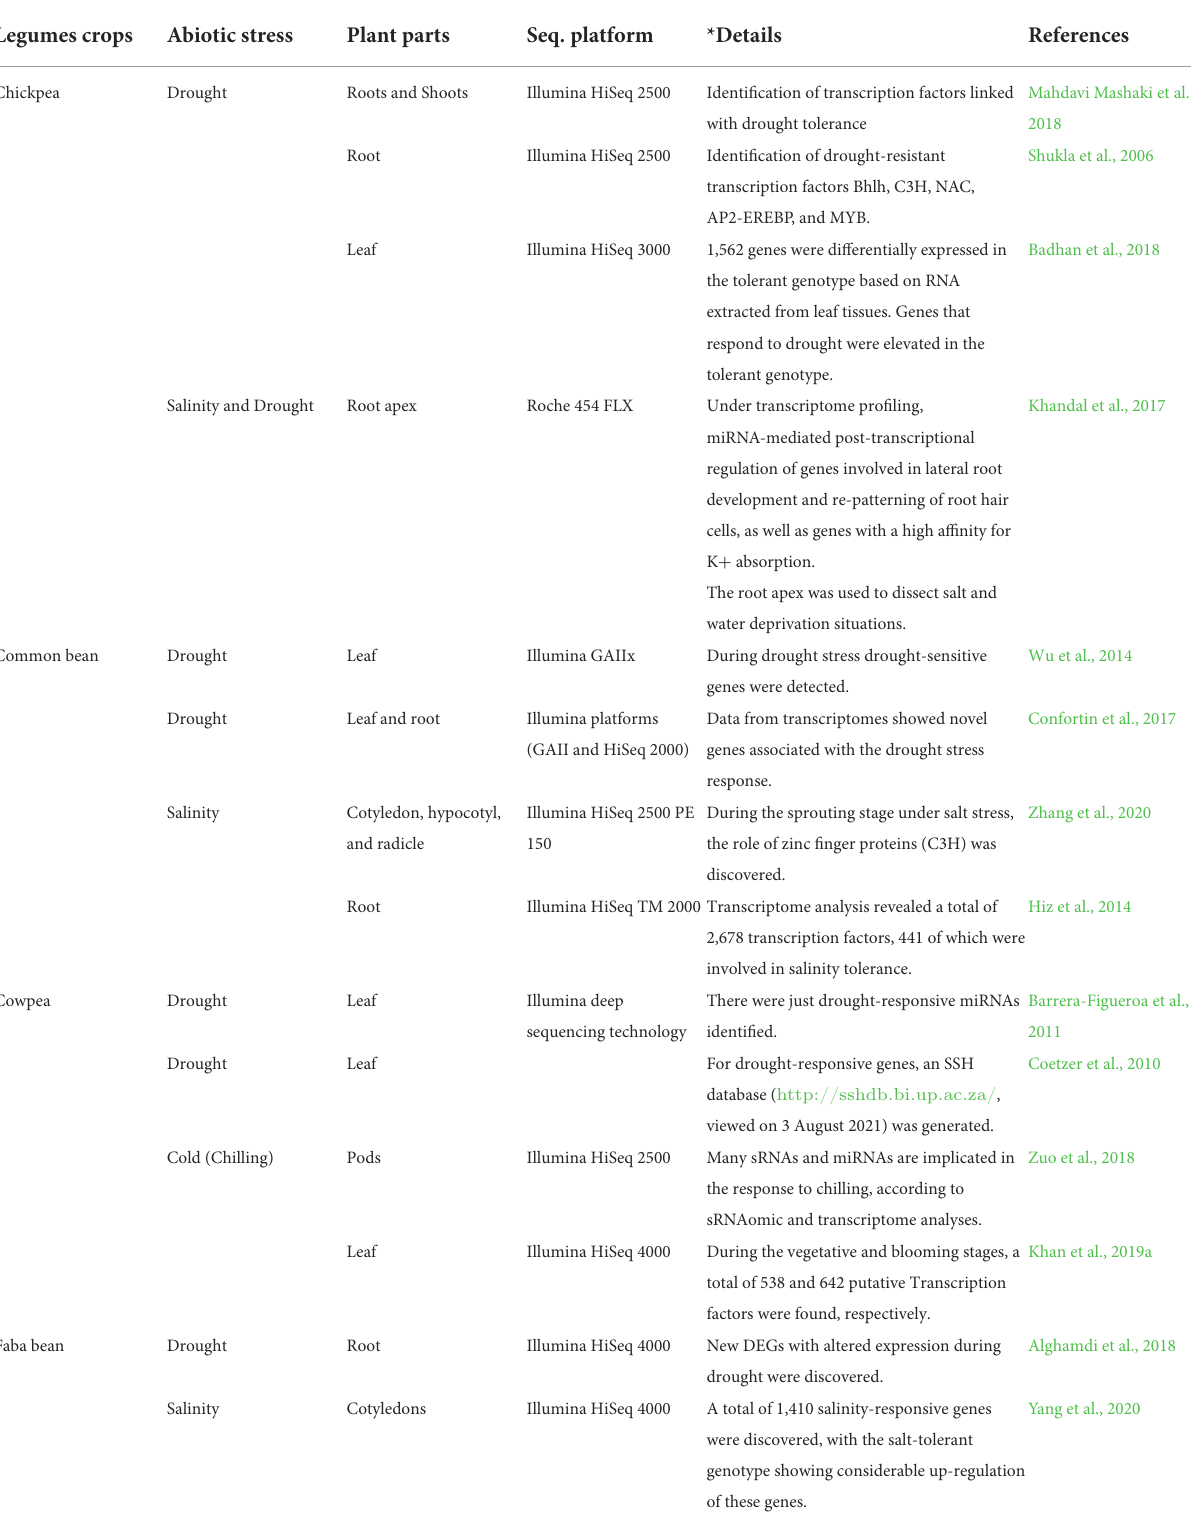
TABLE 7 Transcriptome profiling of legumes crops under abiotic stress using RNA-Seq. Legumes